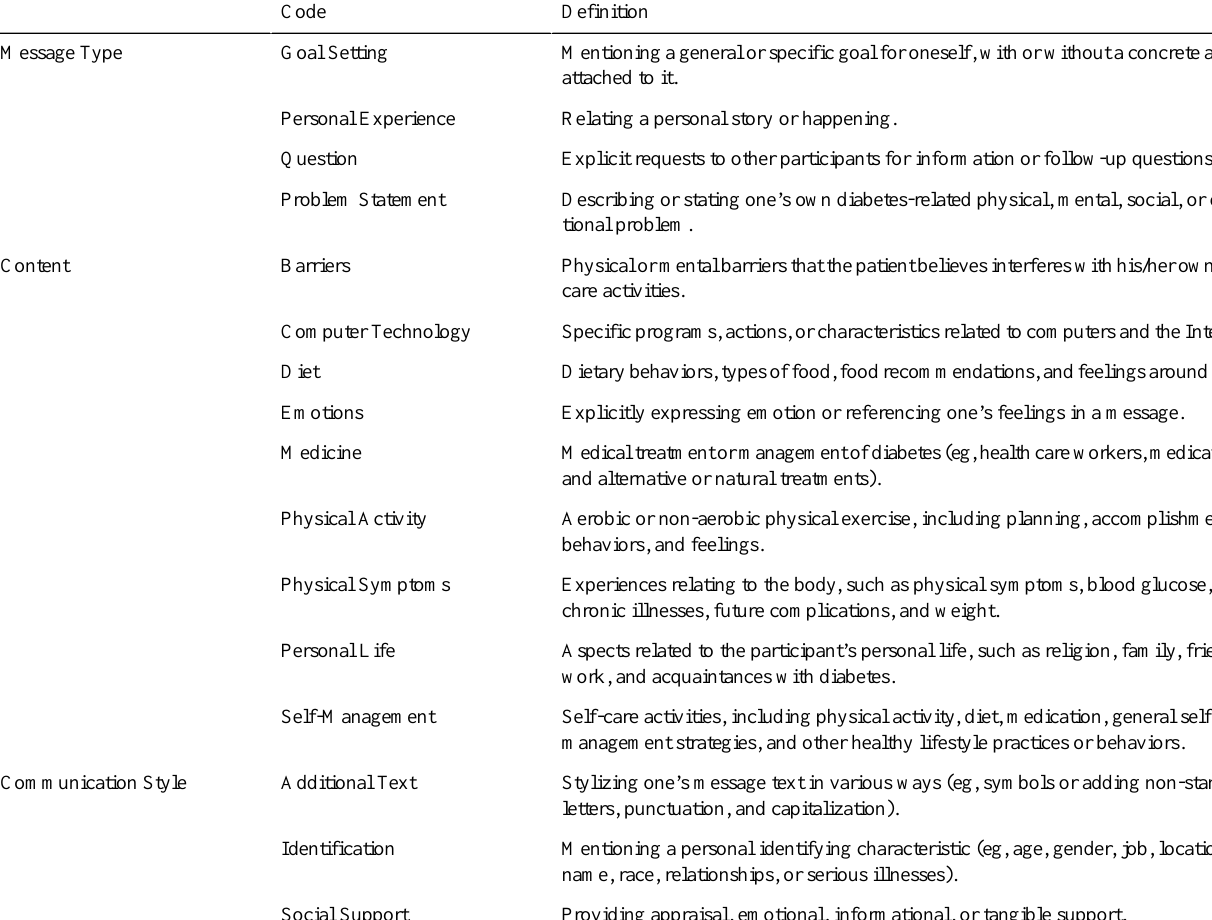
Table 2. Primary codes in message type, content, and communication